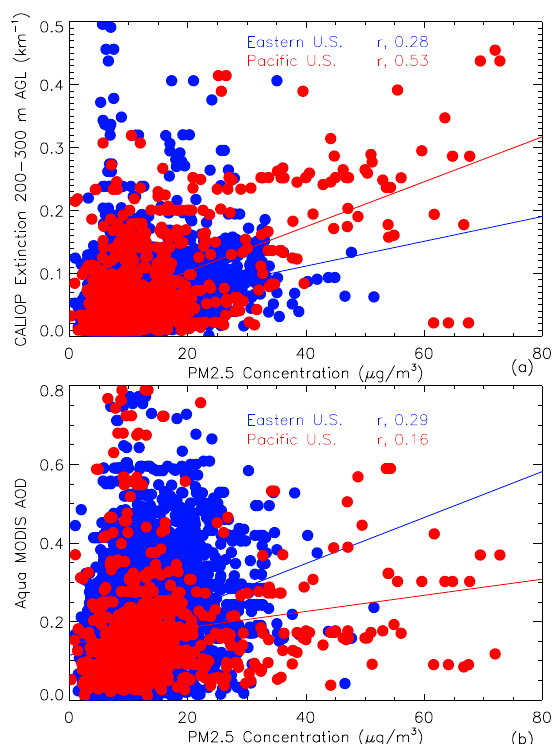
Figure 11. For the eastern (blue) and Pacific (red) US time zones, 2-year (2008–2009) scatterplots of daily PM 2 . 5 concentrations ver- sus (a) cloud-free 5km CALIOP dry mass 0.532µm extinction at the 200–300m a.g.l. layer (averaged within 100km), and (b) opera- tional Aqua MODIS AOD (averaged within 1 ◦ ) and the day of each respective PM 2 . 5